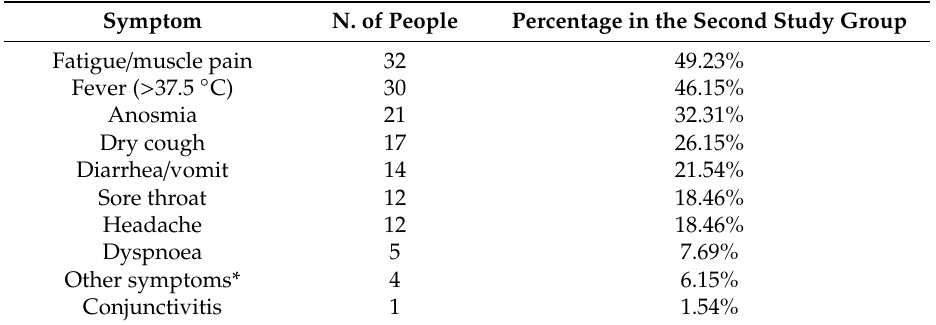
Table 1. Reported symptoms by the second study group (number of people showed up for the second survey: 65). Symptom N. of People Percentage in the Second Study Group Fatigue / muscle pain 32 49.23% Fever ( > 37.5 ◦